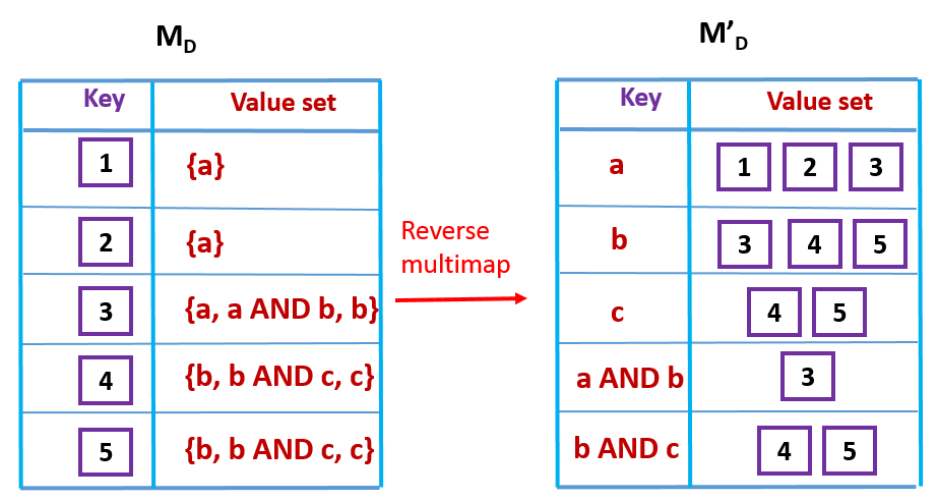
Figure 7. Step 1 of Algorithm 1, assuming the information in Figure